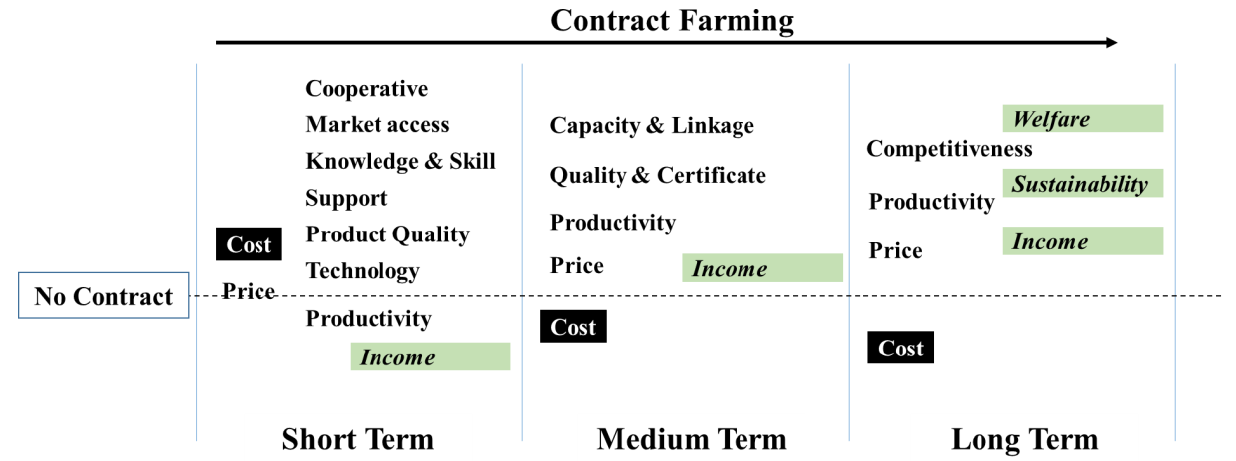
Figure 3. The mechanism of how contract farming affects income, sustainability, and welfare.